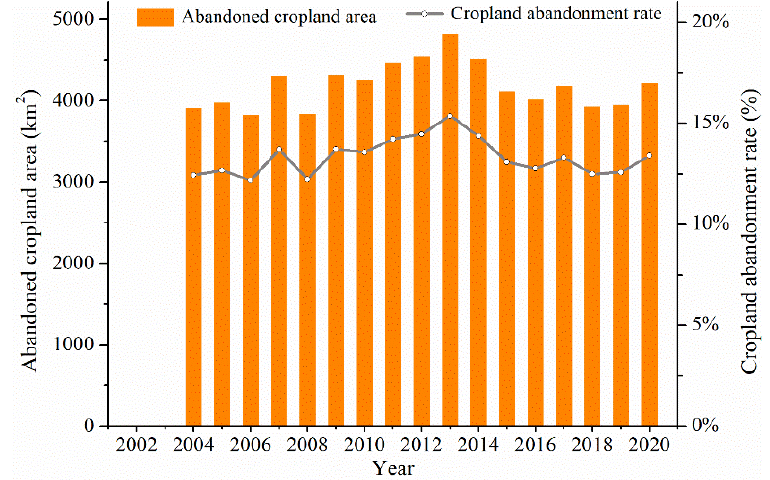
Figure 4. Abandoned cropland area and rate for the period 2001–2020.